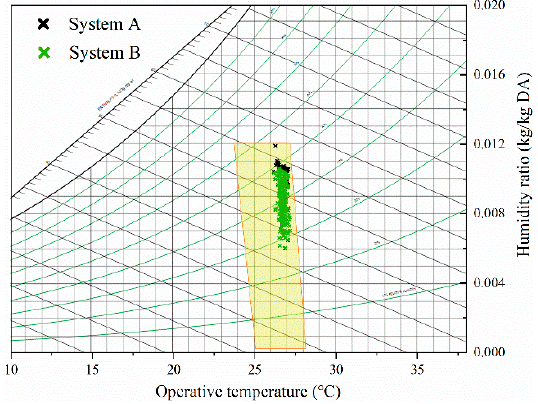
Figure 7. Indoor thermal comfort results for the HPDC systems.